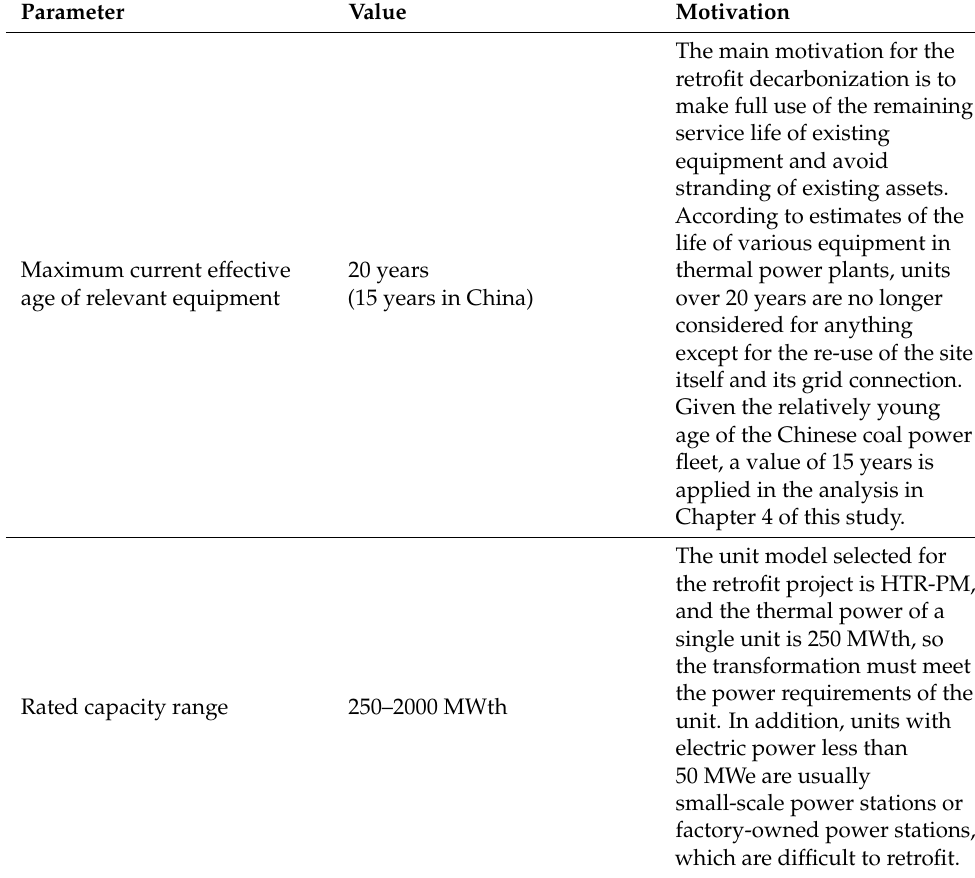
Table 1. Threshold requirements for coal unit inclusion in retrofit decarbonization